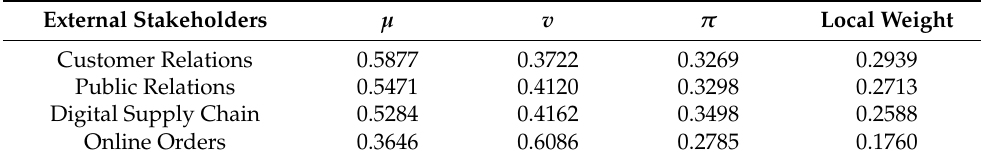
Table 8. Spherical fuzzy and defuzzified weights for sub-criteria of external stakeholders.